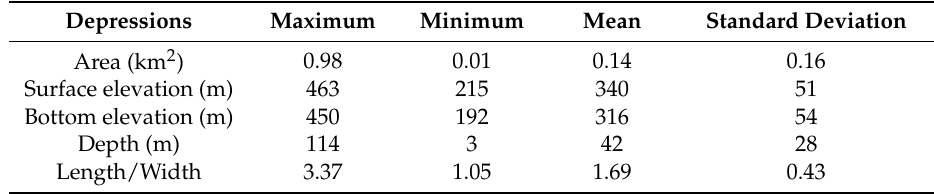
Table 2. Morphological characteristics of depressions in study